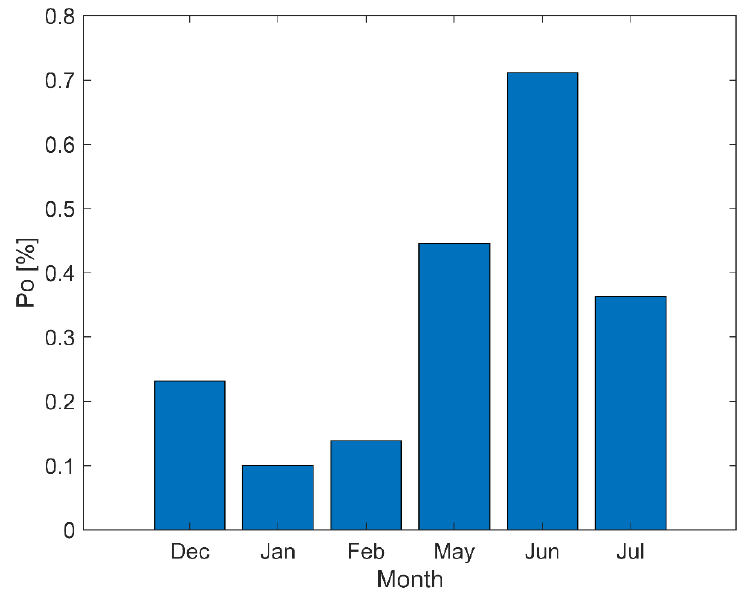
Figure 21. Outage probability comparison between rainiest and driest months.